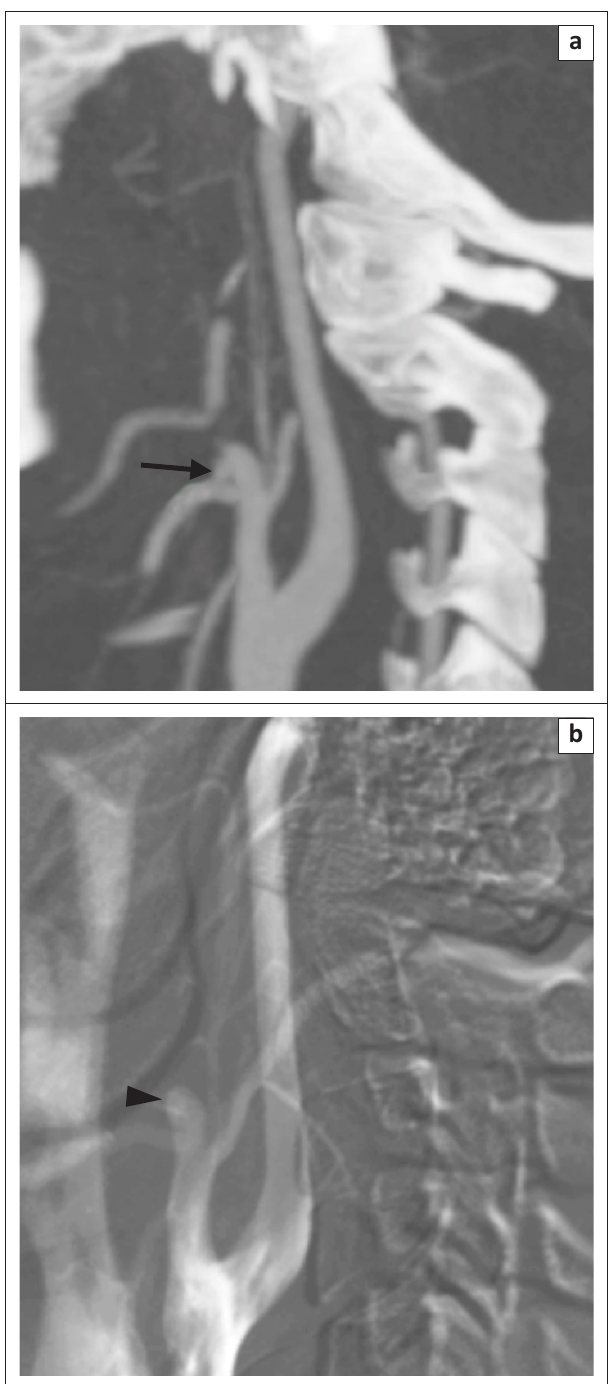
MIP, maximum intensity projections; CTA, computed tomography angiography; ECA, external carotid artery DSA, digital subtraction angiography; AVF, arteriovenous fistula. FIGURE 5: (a) The sagittal reformatted MIP CTA was interpreted as an ECA pseudo-aneurysm (arrow). DSA revealed an ECA transection (arrowhead,